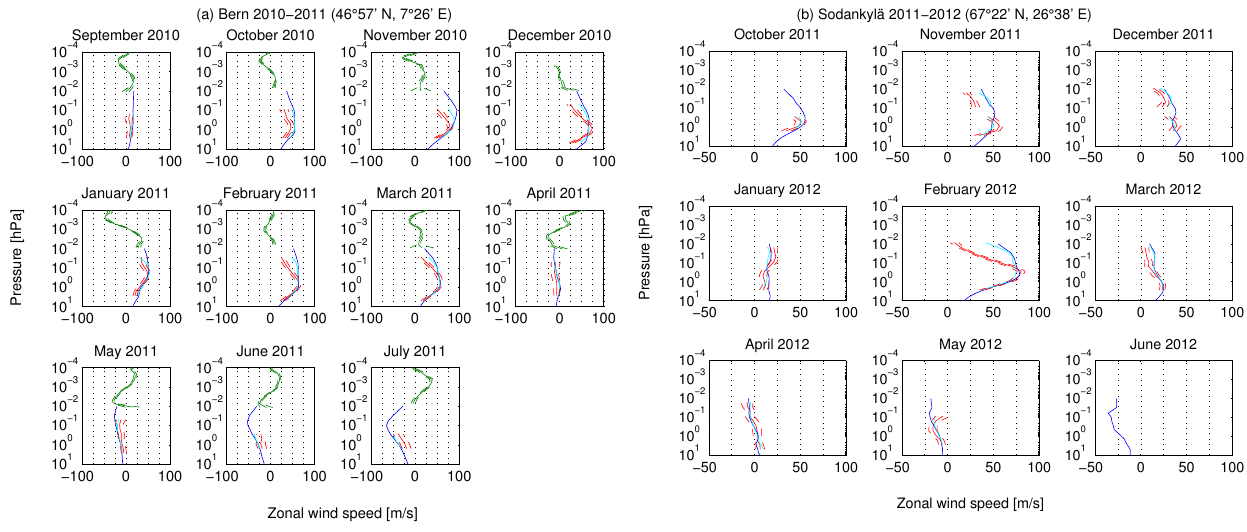
Figure 16. Monthly mean profiles of zonal wind measured by the old WIRA double sideband receiver (red) compared to ECMWF operational analysis data (blue), to the ECMWF profile convolved with WIRA’s averaging kernels (cyan) and to TIDI data (green). The dashed lines represent the error estimates for the averaged measurement